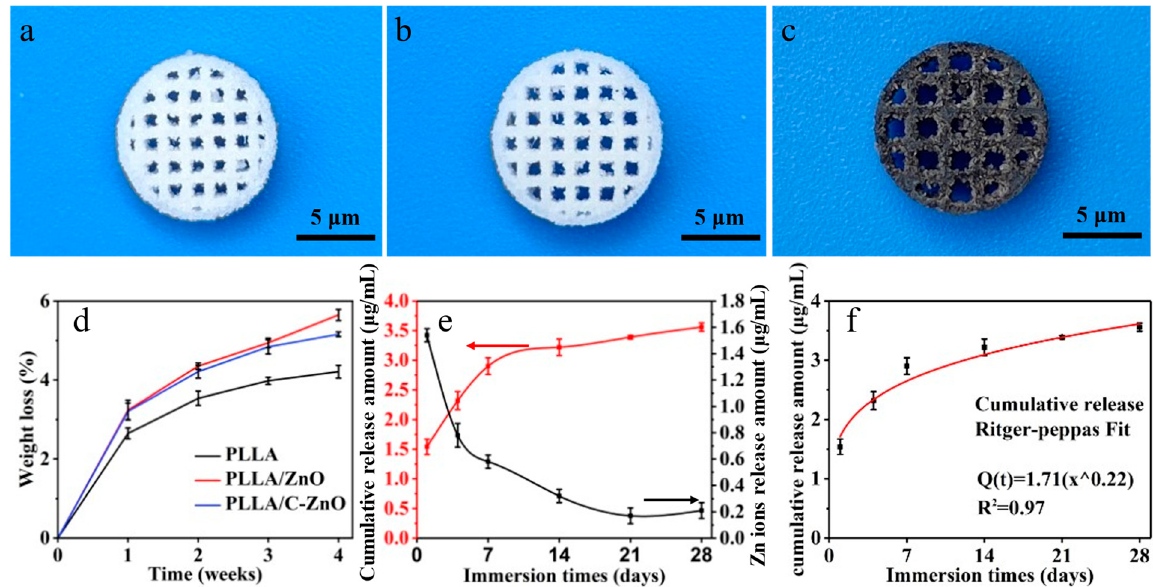
Figure 3. The real images of the ( a ) PLLA, ( b ) PLLA/ZnO, and ( c ) PLLA/C-ZnO scaffolds. ( d ) Weight loss of the scaffolds. ( e ) Cumulative and non-cumulative release amounts of Zn ions. ( f ) Ritger– Peppas fitting of the release curve of the PLLA/C-ZnO scaffold.